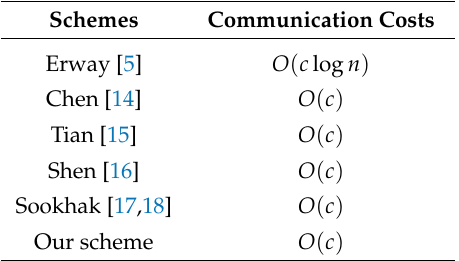
Table 1. Comparison of communication